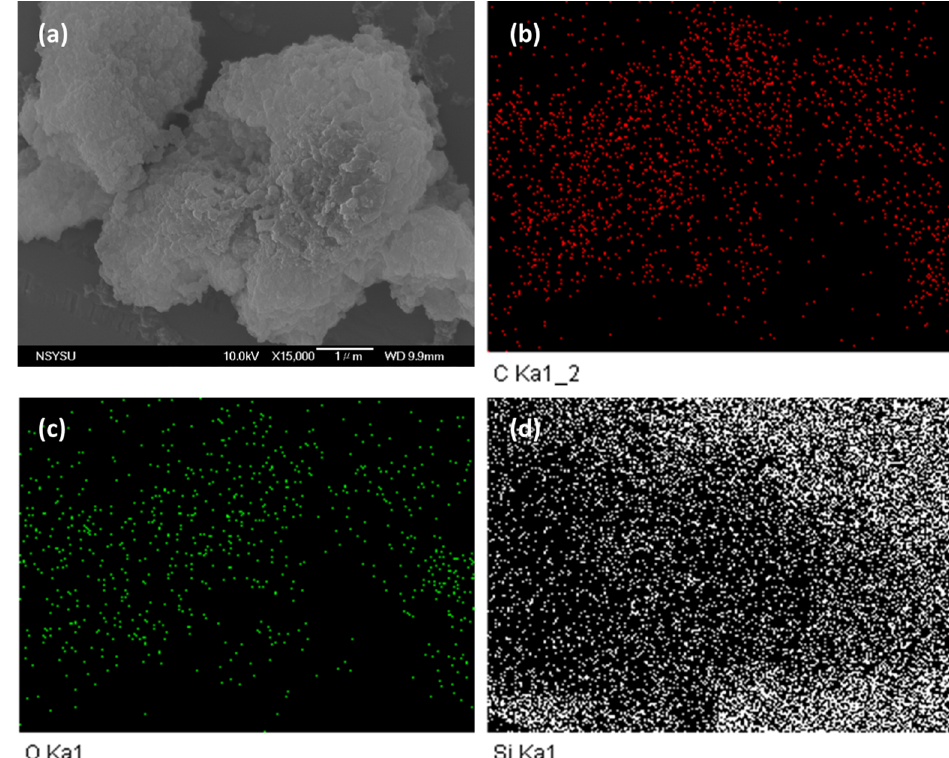
Figure 5. SEM images and their corresponding element mapping for ( a – d ) OVS-A HPP.